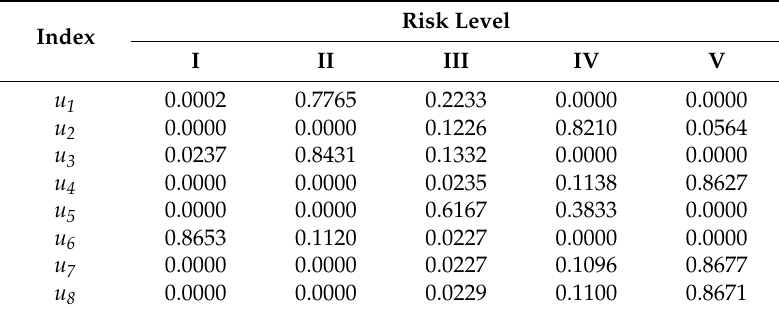
Table 18. Certainty degrees of Guiyang City in Guizhou province.